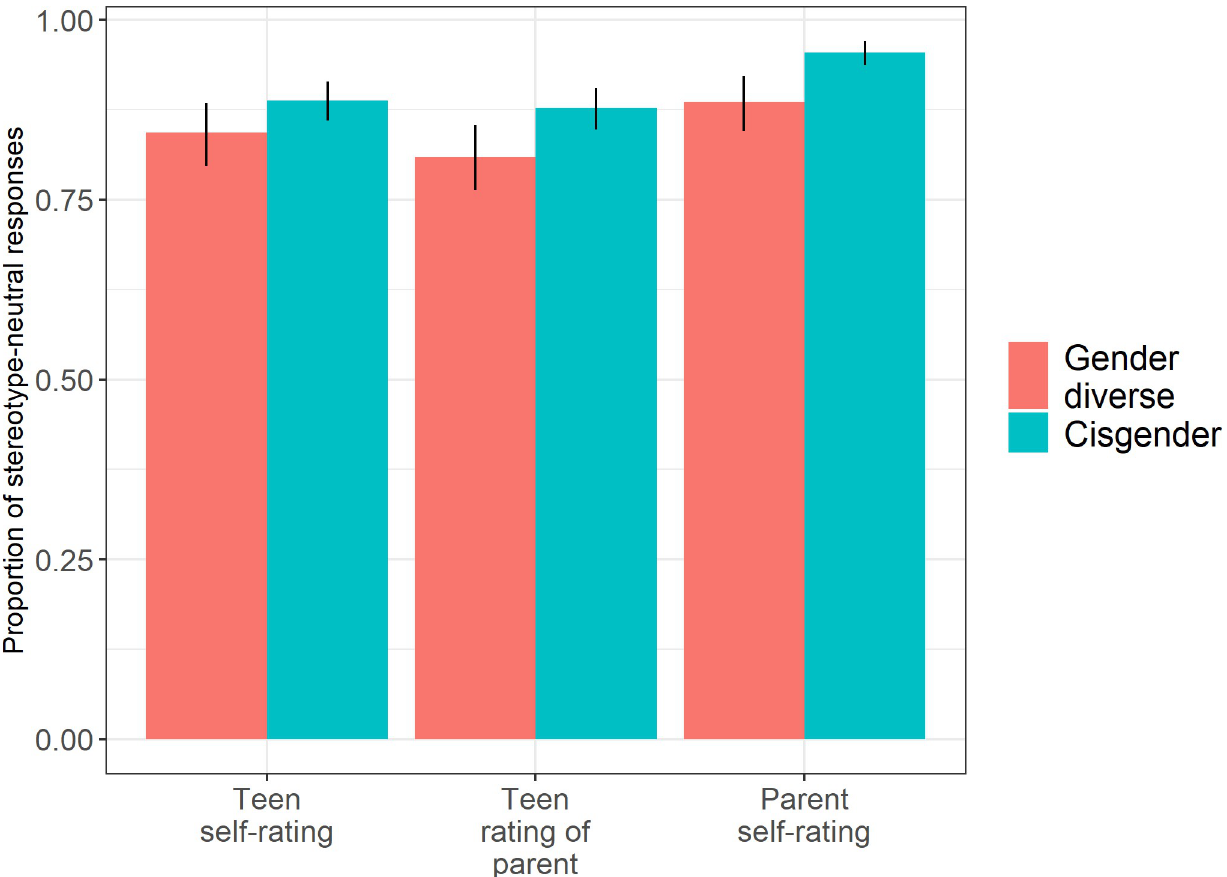
Fig 1. Proportion of non-stereotyped responses (i.e., “both women and men”), by gender identity condition (either gender diverse , N = 144 dyads, or cisgender , N = 174 dyads). Some parents appeared in multiple dyads.